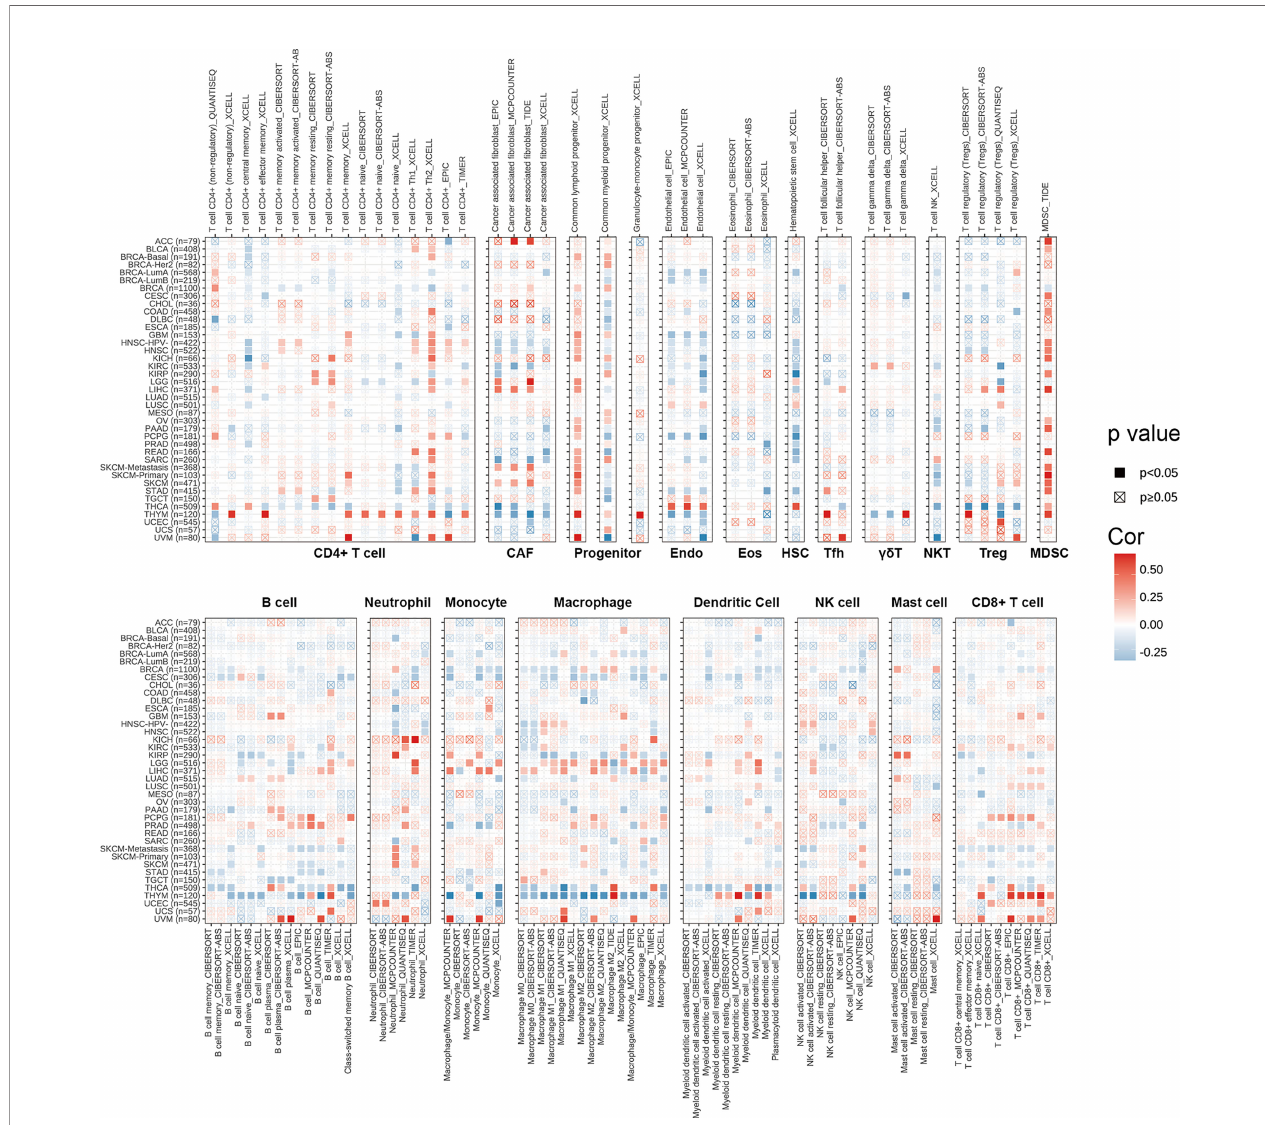
FIGURE 4 | The correlations of SPA17 expression and the in fi ltration levels of CD4+ T cells, CAF, progenitor, Endo, Eos, HSC, Tfh, gd T, NKT, regulatory T cells (Tregs), B cells, neutrophils, monocytes, macrophages, dendritic cells, NK cells, Mast cells and CD8+ T cells in cancers. Positive correlation in red and negative correlation in